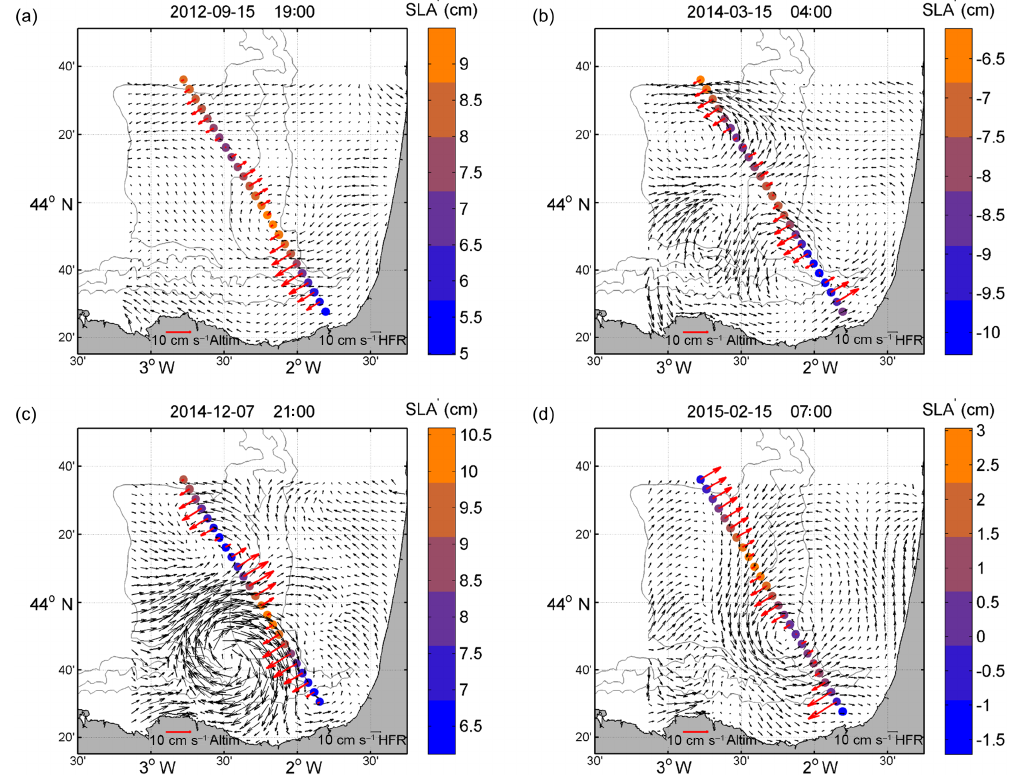
Figure 8. Four mesoscale eddies observed in the study area. The dots show the points of track 248 of the CMEMS database. SLA (cid:48) (cm) values are indicated in the colour scale. Black arrows depict the HFR current fields. Red arrows correspond to across-track AC G derived from the SLA (cid:48) values in the dots. Grey lines: 200, 1000, and 2000m isobaths. Note that the scale of each kind of arrow is not the